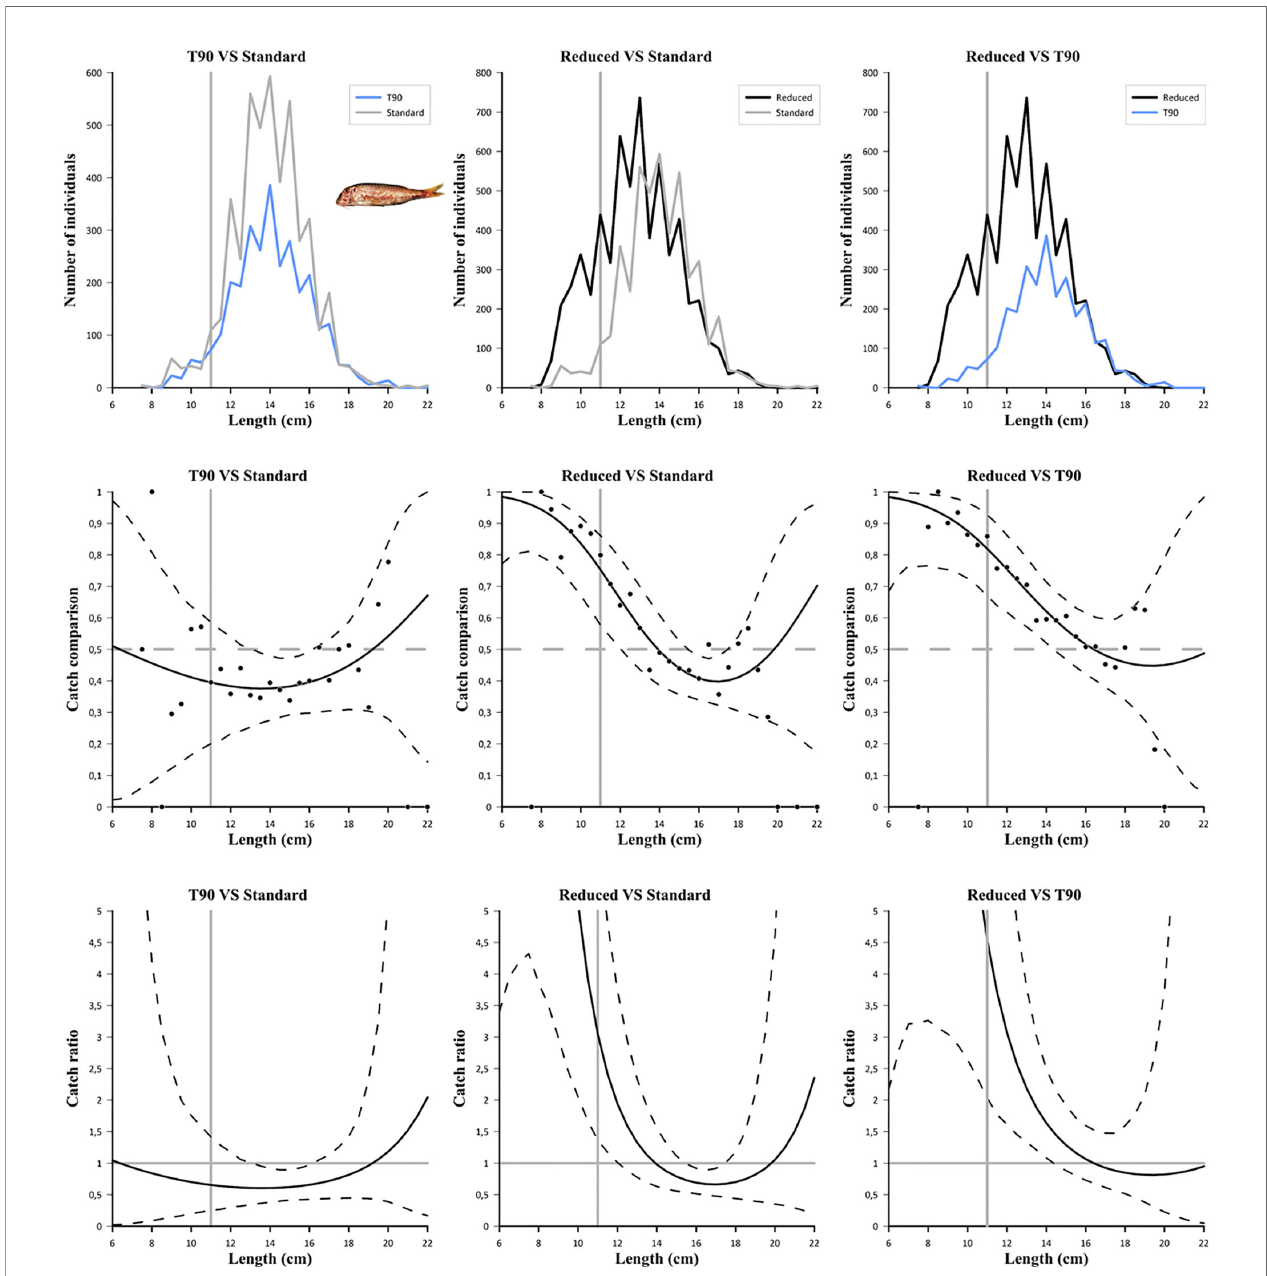
FIGURE 4 | Upper graph: Length frequency distribution of red mullets caught by the con fi gurations tested (Standard, Reduced and T90). Middle graph represents the modelled catch comparison rate, and lower graph the catch ratio (black line). Black circles represent the experimental rate, and the black stippled curves represent 95% CIs . The grey horizontal line at 0.5 and 1.0 represents the point at which both con fi gurations have equal catch rates. The grey vertical line represents the MCRS for red